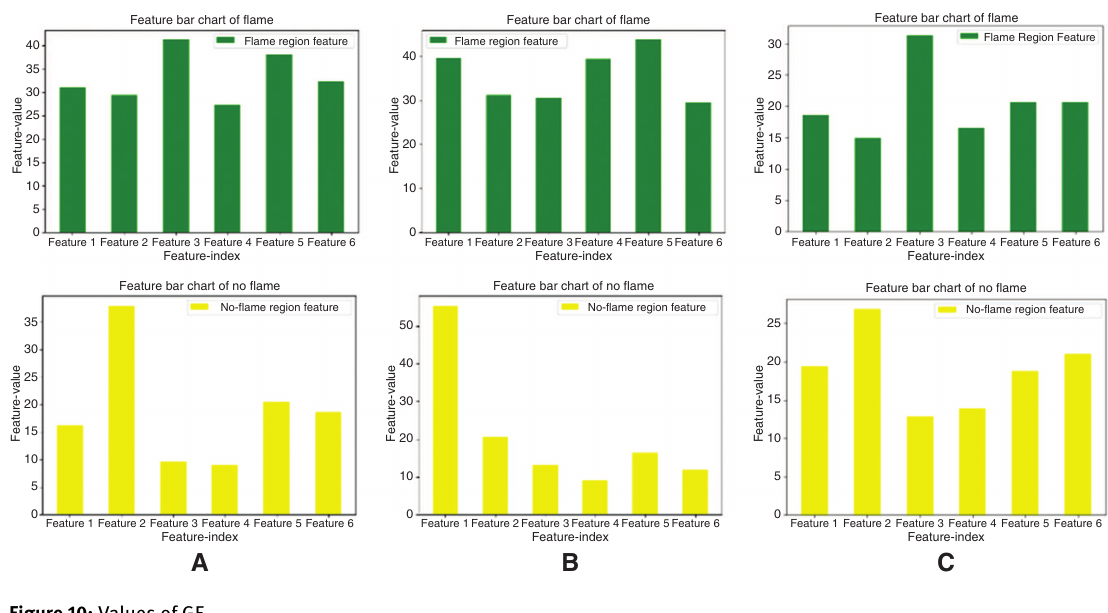
Figure 10: Values of GF. Green represents features from flame regions; yellow represents features from non-flame regions. (A), (B), and (C) are from different image samples. Table 2: Eigenvalue and Eigenvector.